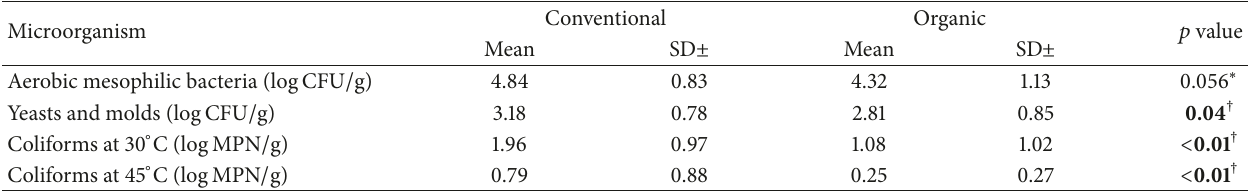
Table 2: Mean counts of aerobic mesophilic bacteria, yeasts and molds, and coliforms at 30 ∘ C and 45 ∘ C from 70 vegetable samples from organic and conventional